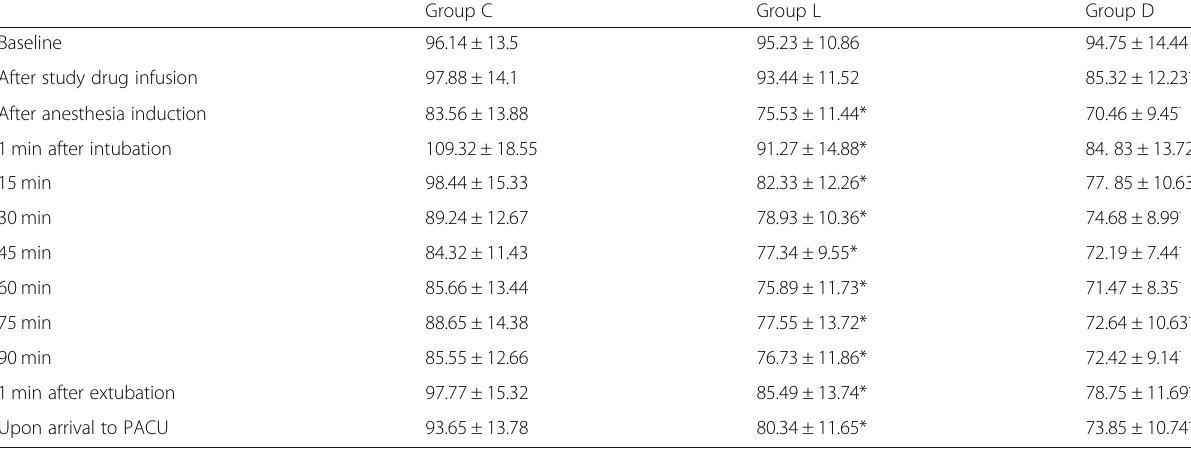
Table 2 Mean arterial blood pressure (mmHg) changes in the study groups (data are presented as mean ±